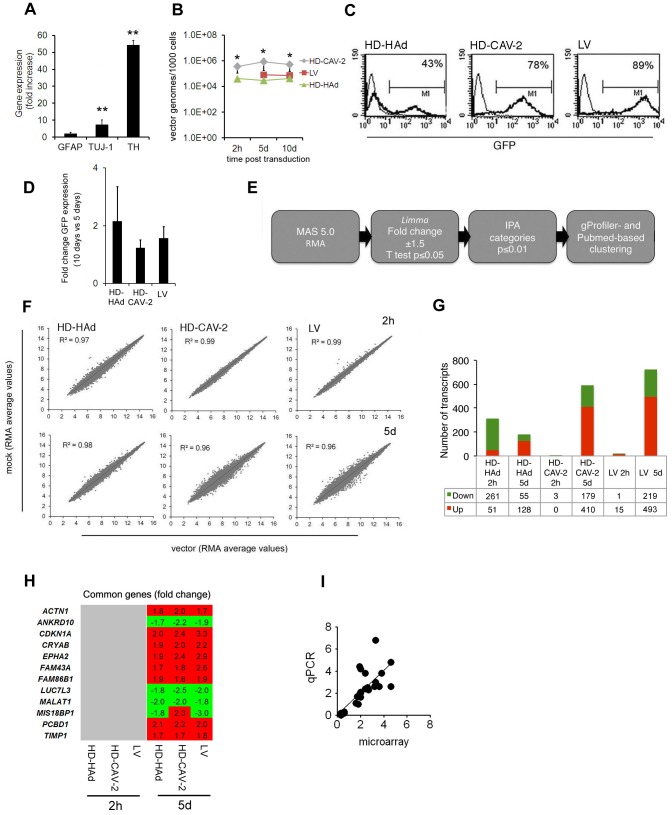
hmNPCs differentiation and transduction.(a) qPCR quantification of the markers GFAP, TUJ-1 and TH in differentiated hmNPCs presented as fold changes relative to undifferentiated cells. Values are averages from two independent experiments and SD is shown. p-values are determined by a two-tailed paired Student's t test from the ΔCq values of differentiated with respect to the undifferentiated condition; ** p<0.01. (b) qPCR quantification of internalized vector copies performed on differentiated hmNPCs transduced with HD-HAd, HD-CAV-2 and LV vectors at an MOI of 1000 vector genomes/cell. Results are presented as average of two independent experiments; SD is shown. Data were compared by one-way ANOVA followed by Tukey's post- hoc test between vectors for each time point; * p<0.05. (c–d) Differentiated hmNPCs were transduced with HD-HAd, HD-CAV-2 and LV at an MOI of 1000 vector genomes/cell and were analysed for GFP expression by FACS at 5 days (c), and by qPCR at 5 and 10 days (d). FACS results are representative of three independent experiments. qPCR data are the average of triplicate samples and are presented as fold change values of 10 days values versus 5 days. SD is shown. (e) Schematic representation of chip analysis workflow. (f) Scatter plots showing on the y axis the Robust Multichip Average (RMA) expression values for mock cells, and in x RMA values for of HD-HAd, HD-CAV-2 and LV transduced samples, at the 2 h and 5 days posttransduction time points. To obtain RMA, background corrected raw intensity values were Log2 transformed and quantile normalized. All absent and control probes were excluded from this analysis. Values represent the average of the three independent replica experiments. Trend lines and R2 value are indicated. (g) Number of genes upregulated and downregulated with a fold change ≤−1.5 or ≥+1.5 in response to HD-HAd, HD-CAV-2 and LV at 2 h and 5 days. Red: upregulated genes; green: downregulated genes. (h) Heat maps of genes commonly modulated by HD-HAd, HD-CAV-2 and LV and at 2 h and 5 days posttransduction. The relative fold change values are indicated; in red, upregulated genes, in green, downregulated, and in grey, genes with unmodified expression with respect to mock. (i) Correlation between relative fold changes measured by microarray and qPCR. Each point represents the fold change of a single gene relative to the mock at a given time point; x and y axes are microarray and qPCR fold changes, respectively. Number of xy pairs = 28. Pearson's r correlation = 0.75; p<0.0001 (2-tailed). All samples were tested in triplicate and data are reported as mean value. Tested genes were the following: FANCD2, BIRC5, MAD2L1, RAD51, NBN, HIP1B, MYO6, CLTC, CD44, TLR3,TLR4, HAS3, FXN, p53, CDKN1A.